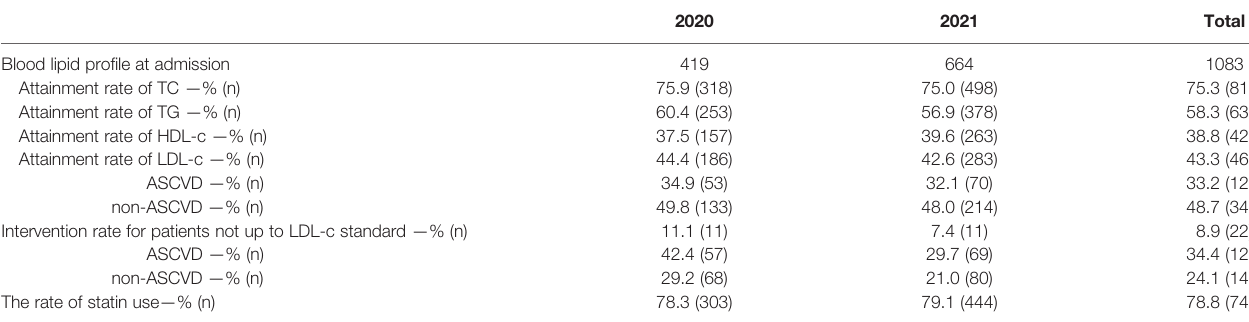
TABLE 6 | Blood lipid and medication of type 2 diabetes inpatients.